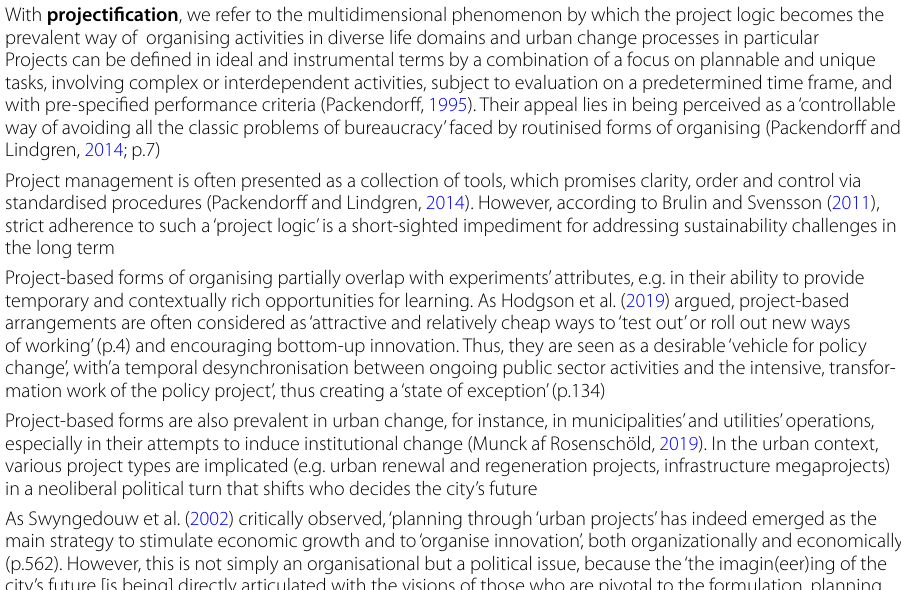
Table 2 Projectification and challenges of projectified contexts in urban